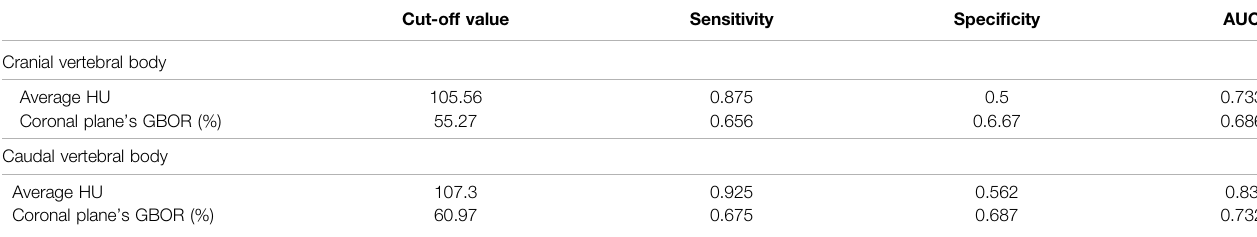
TABLE 6 | The cut-off value, sensitivity and speci fi city of four measurement methods for predicting screw